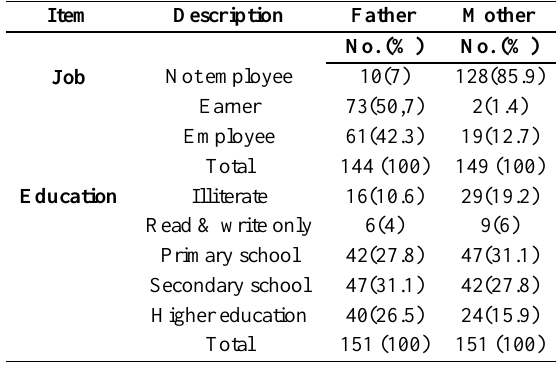
Table 2: Job and Education of